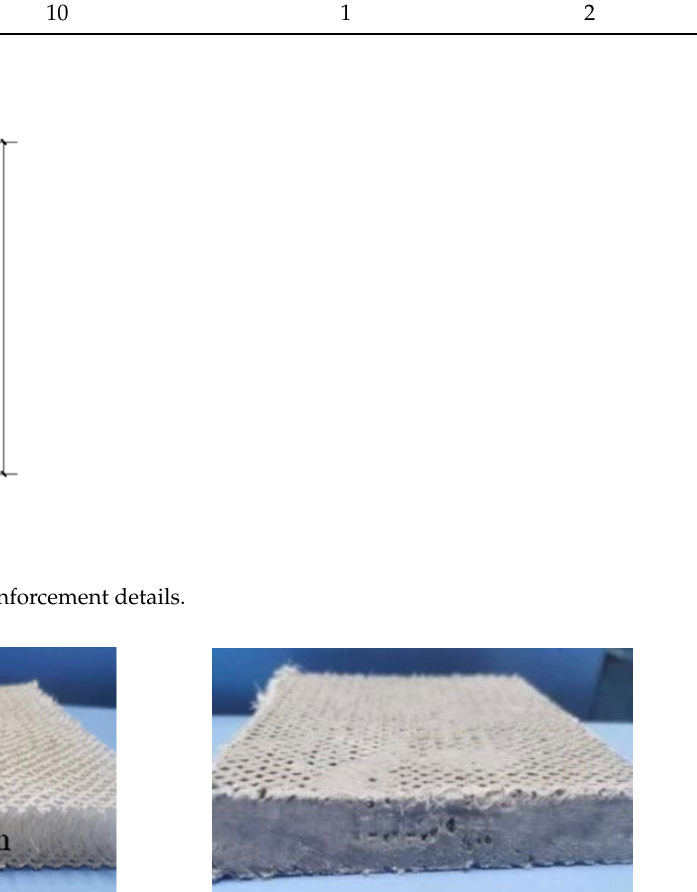
Table 2. Specimen parameters. Figure 2. Physical features of the concrete canvas: ( a ) before and ( b ) after hardening.